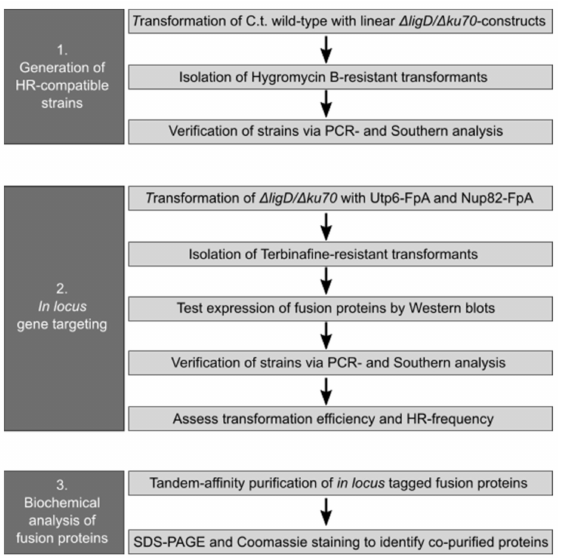
Figure 4. Schematic overview of the experimental steps needed to generate, verify and analyze HR-derived strains in C. thermophilum obtained by in locus gene